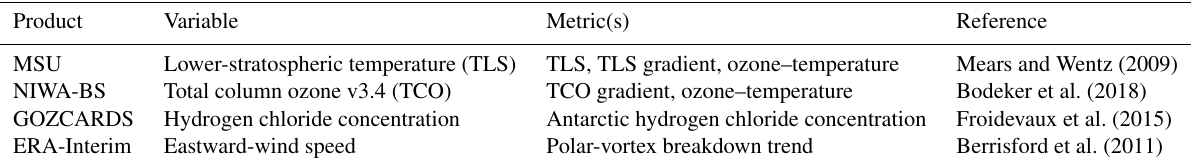
Table 2. The observational products and respective variables used to construct metrics on which to weight the models. MSU: Microwave Sounding Unit. NIWA-BS: National Institute of Water and Atmospheric Research – Bodeker Scientific. GOZCARDS: Global OZone Chem- istry And Related trace gas Data records for the Stratosphere. ERA-Interim: European Centre for Medium-Range Weather Forecasts – ECMWF –